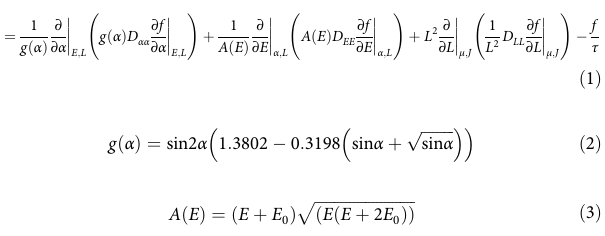
Methods Cassini data . The values for the gyro frequency have been determined from magnetic data taken by the Cassini MAG instrument. The plasma frequency is calculated from data taken by the Langmuir probe on the RPWS instrument on Cassini. Radiation Belt Model . The British Antarctic Survey Radiation Belt Model (BAS RBM) uses the well-established method of quasi-linear theory to solve the modi fi ed Fokker Planck equation (Eq. (1)) on a planetary scale 22 .